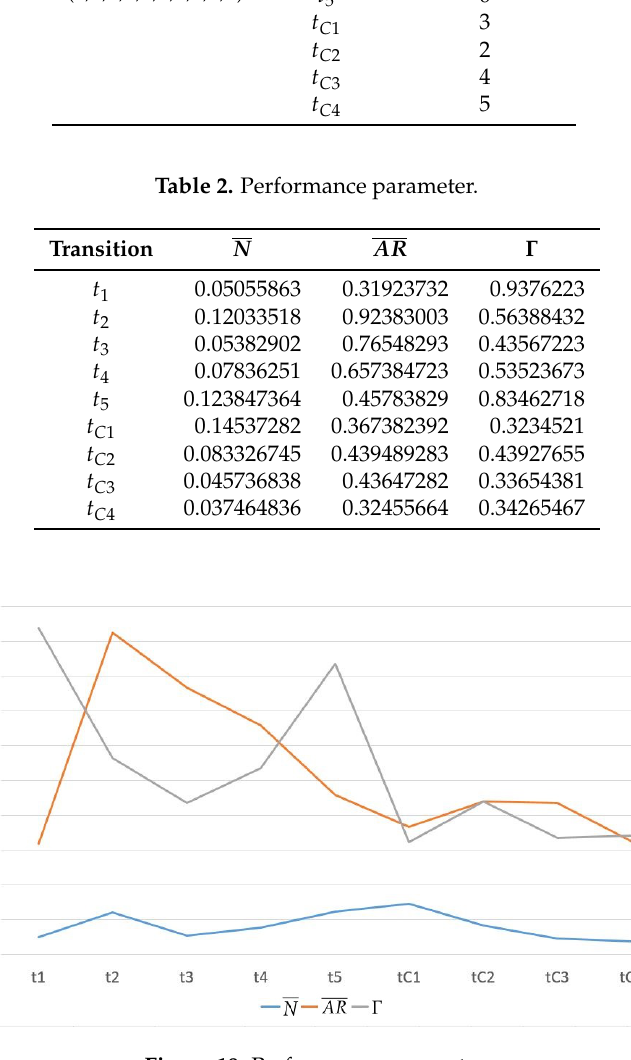
Figure 18. Performance